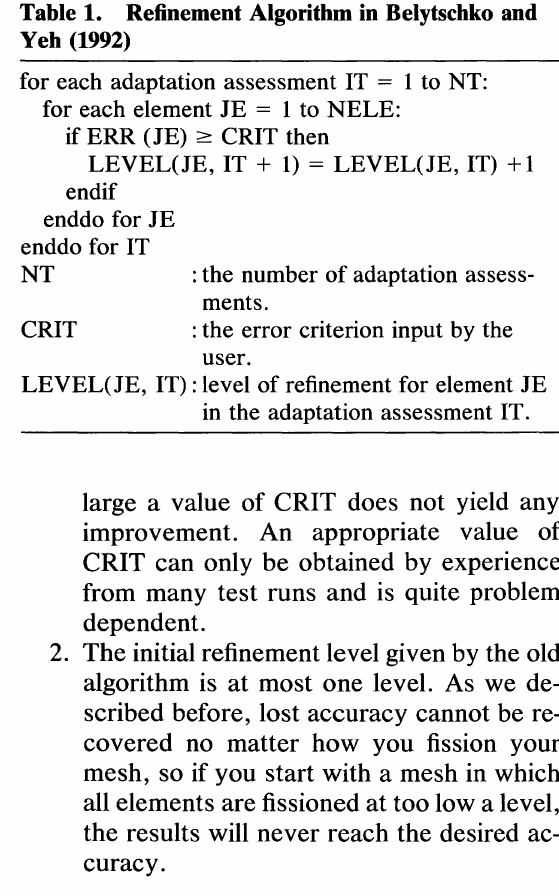
Table 1. Refinement Algorithm in Belytschko and Yeh